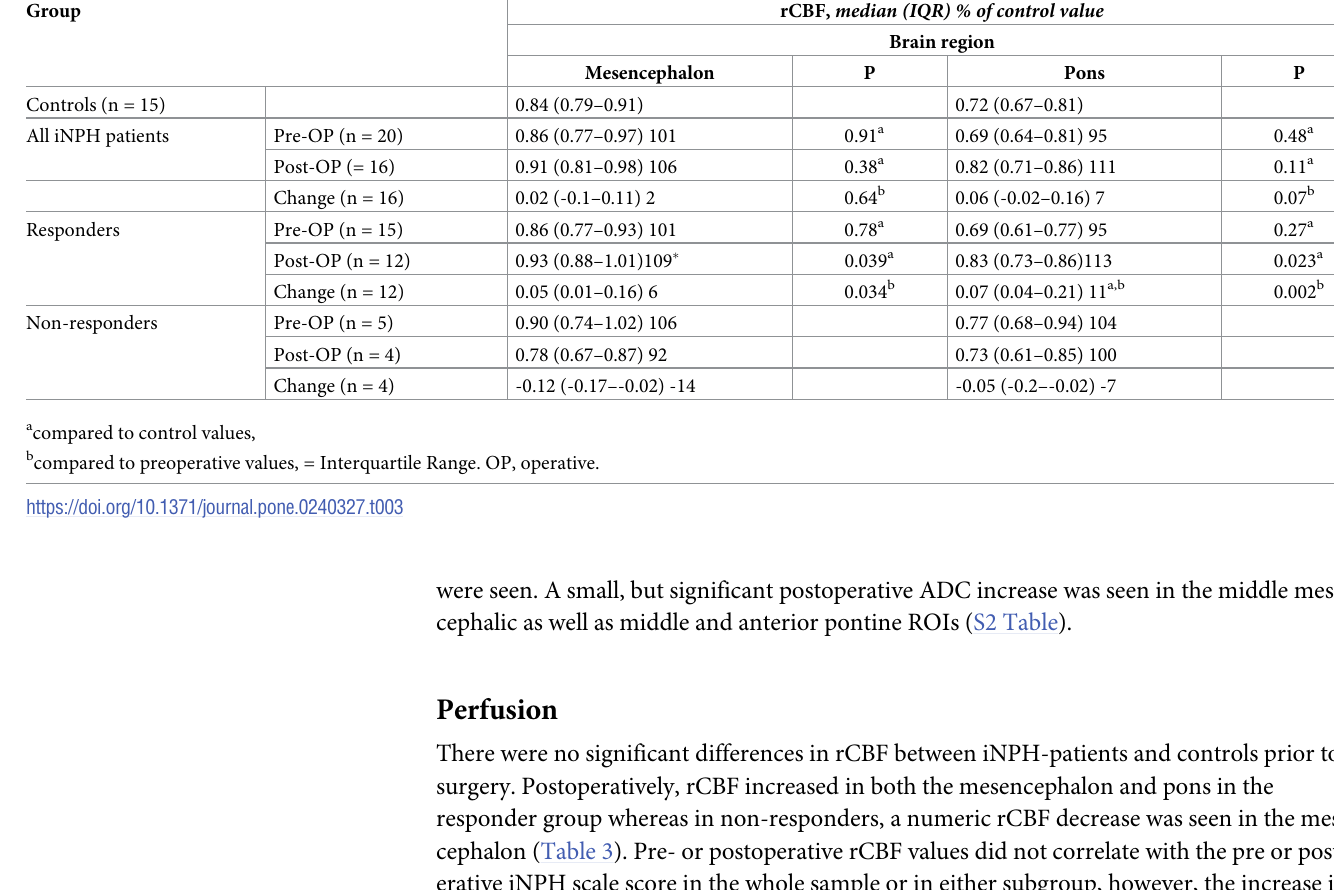
Table 3. Relative cerebral blood flow (rCBF) values in controls and iNPH patients given for the composite ROI in the mesencephalon and pons. Group